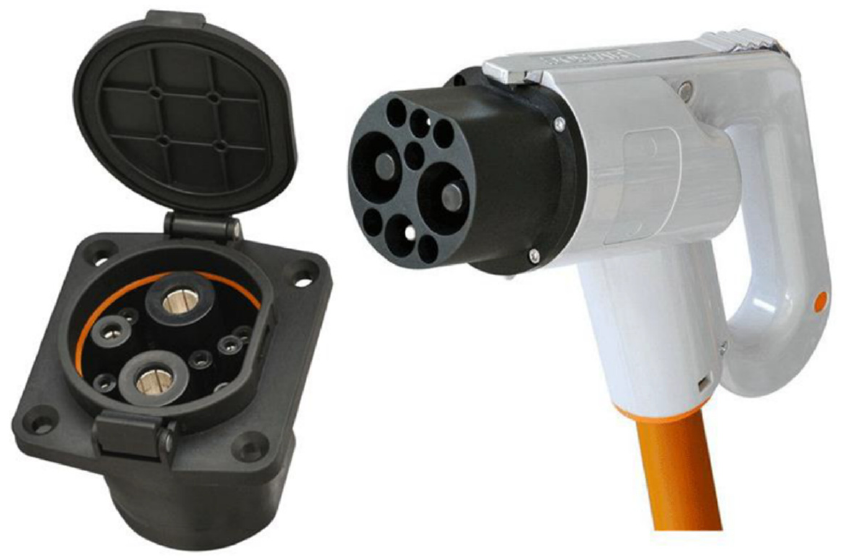
Figure 23. The GB/T DC charging coupler: Inlet ( Left ) and EV Plug ( Right ).